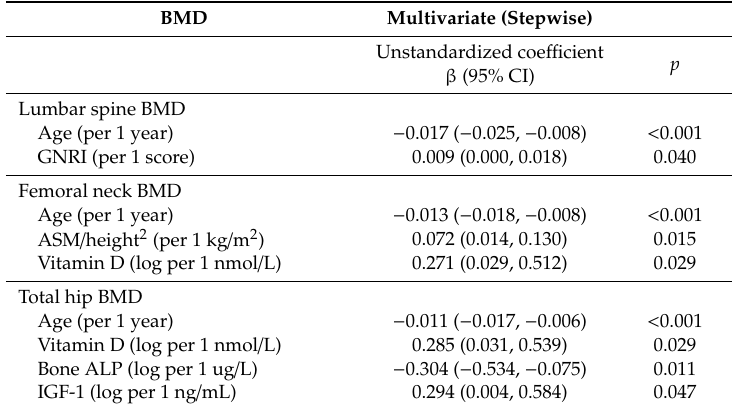
Table 2. Determinants of bone mineral density (BMD) using multivariable stepwise linear regression analysis.